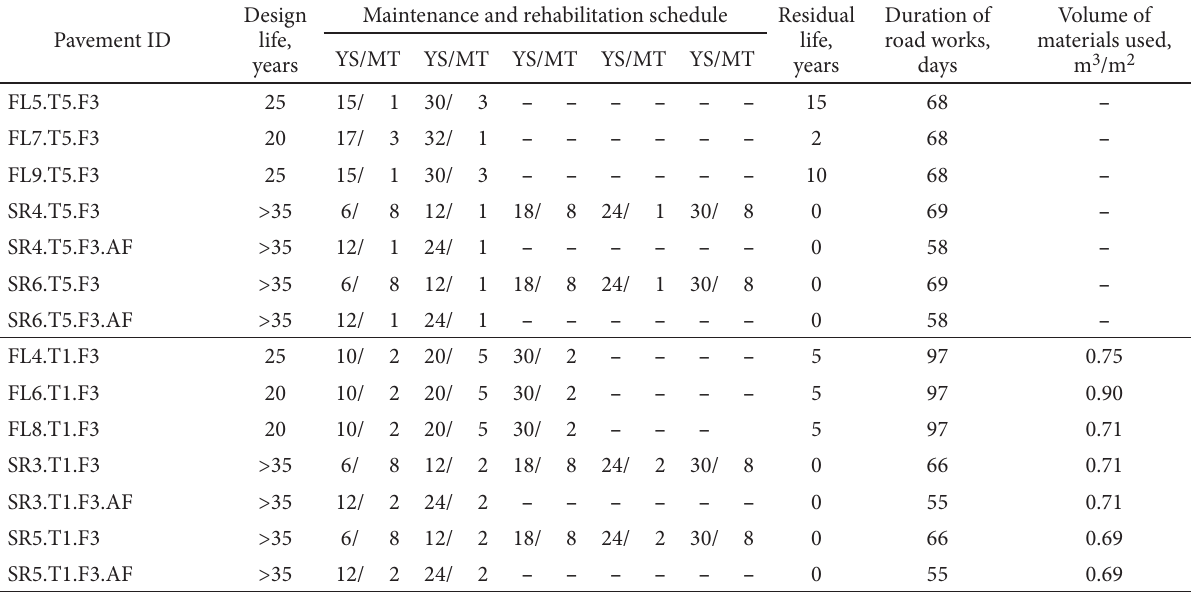
Table 6. Maintenance schedules and total duration of road works per 10 km lane during the analysis period Pavement